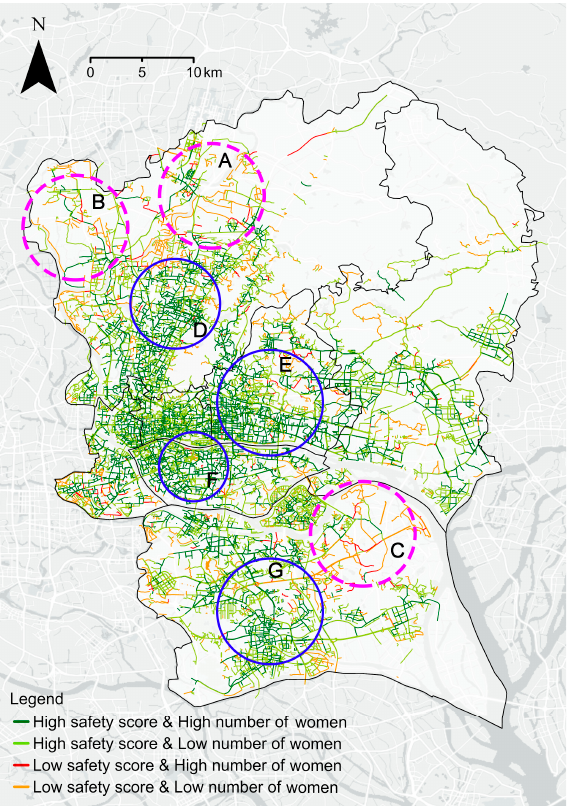
Figure 12. Overlay of street safety scores and the number of females. Map data sources: (c) Open- StreetMap contributors. Table 3. Four types of streets in terms of number, length, and proportion.